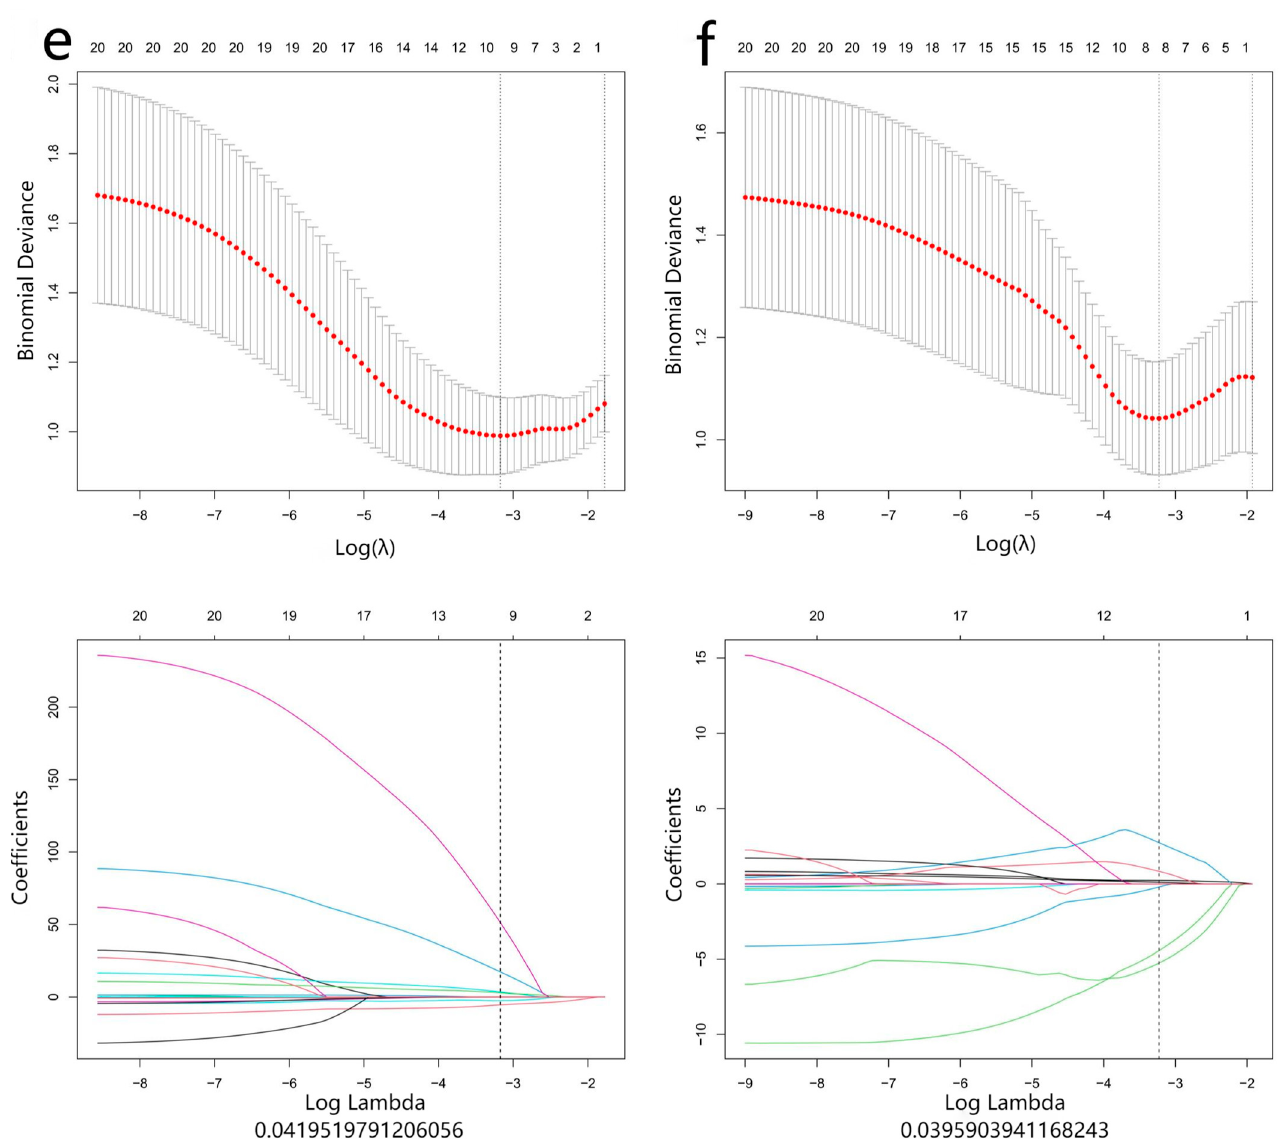
Figure 3. Radiomics feature dimensionality reduction LASSO coefficient distribution map (( a ), ( b ), ( c ), ( d ), ( e ), and ( f ) correspond to the T2, T2*, T1 vibe dixon opp, T1 vibe dixon in, T1 vibe dixon F, and T1 vibe dixon W models, respectively). Each curve represents the change trajectory of the independent variable coefficient corresponding to different penalty coefficients, and the dotted lines are the minimum penalty coefficients.